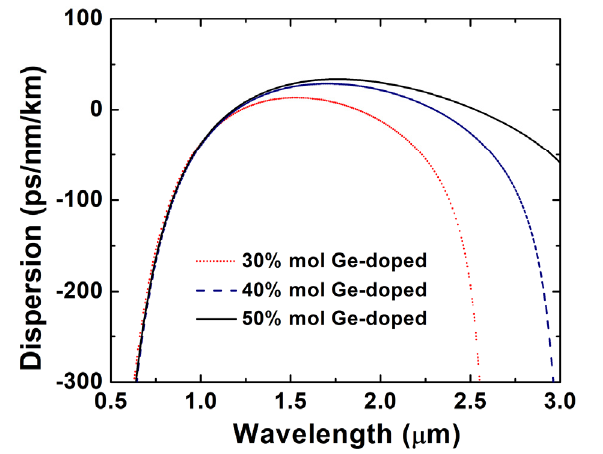
Figure 2. Dispersion-wavelength curves at different Ge-doping concentrations.